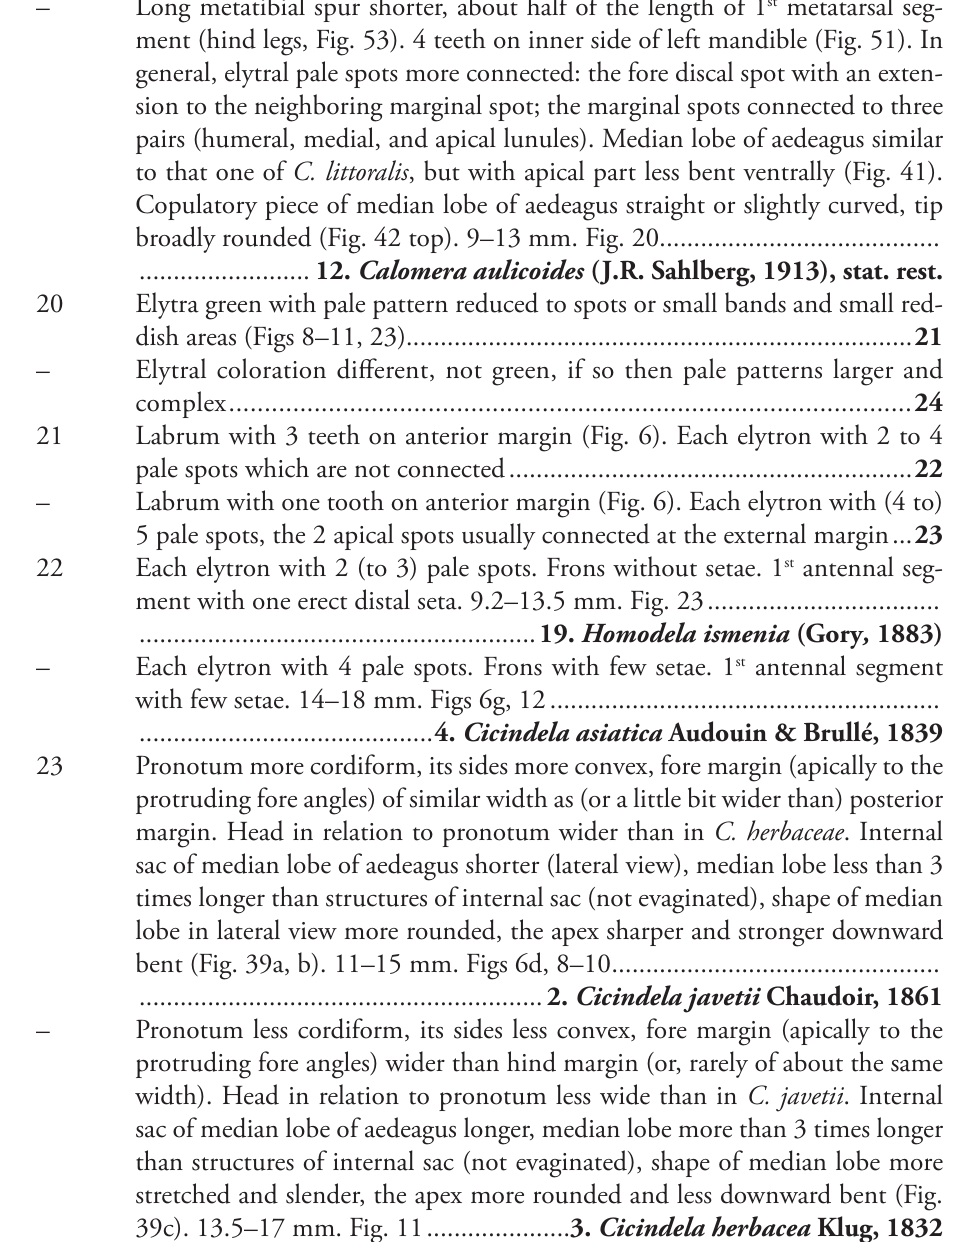
– 1 st antennal segment with 1 distal seta only (Fig. 54 above) .......................26 25 Approximately 5 to 15 white frontal setae at hind margin of eyes. 1 st antennal segment with numerous setae. 11–14 mm. Figs 36, 45a